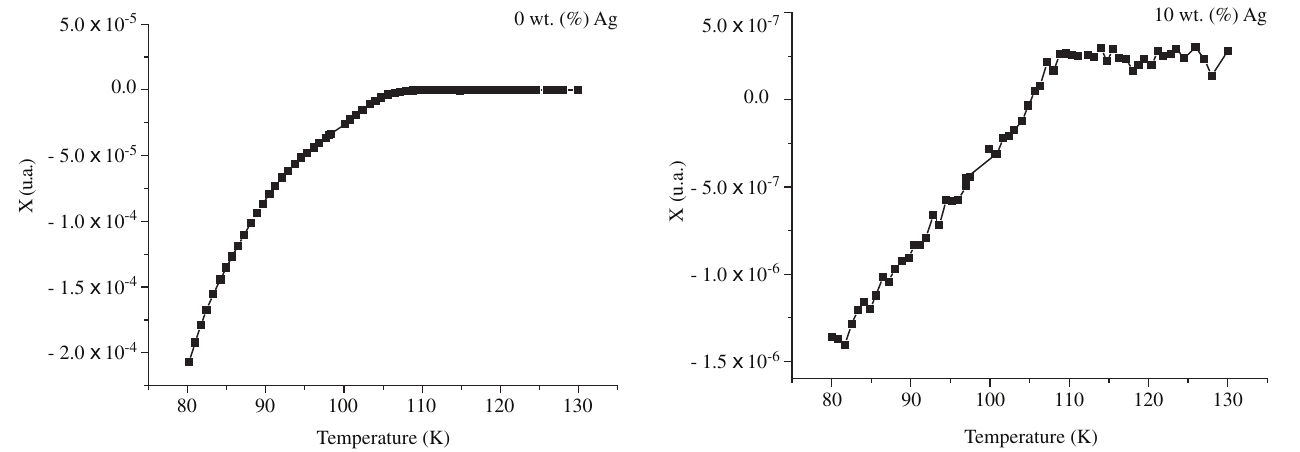
Figure 3. AC Magnetic Susceptibility Analysis of sintered blocks with 0 wt. (%) and 10 wt. (%) Ag (H = 20 Oe, f = 125 Hz).